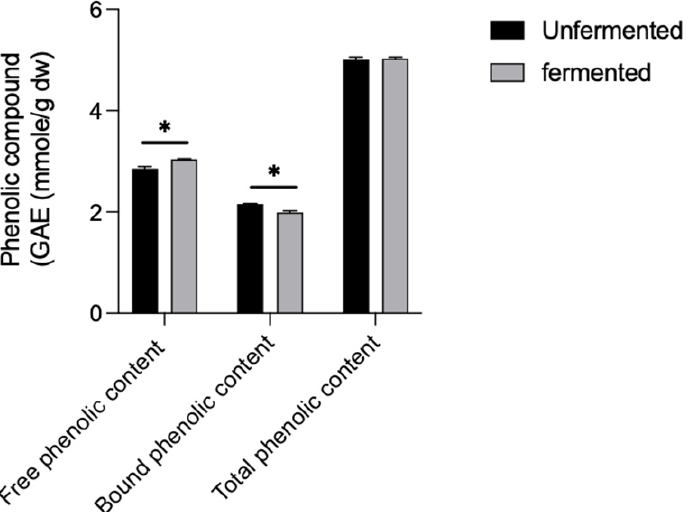
Figure 3. Content of free/bound phenolic compounds in unfermented (black) and fermented (gray) 2.5% turmeric milk. Experimental results were repeated in triplicate, and bar values are the mean ± standard deviation. Statistics were analyzed by t -test, * = p < 0.05. GAE, gallic acid equivalents.